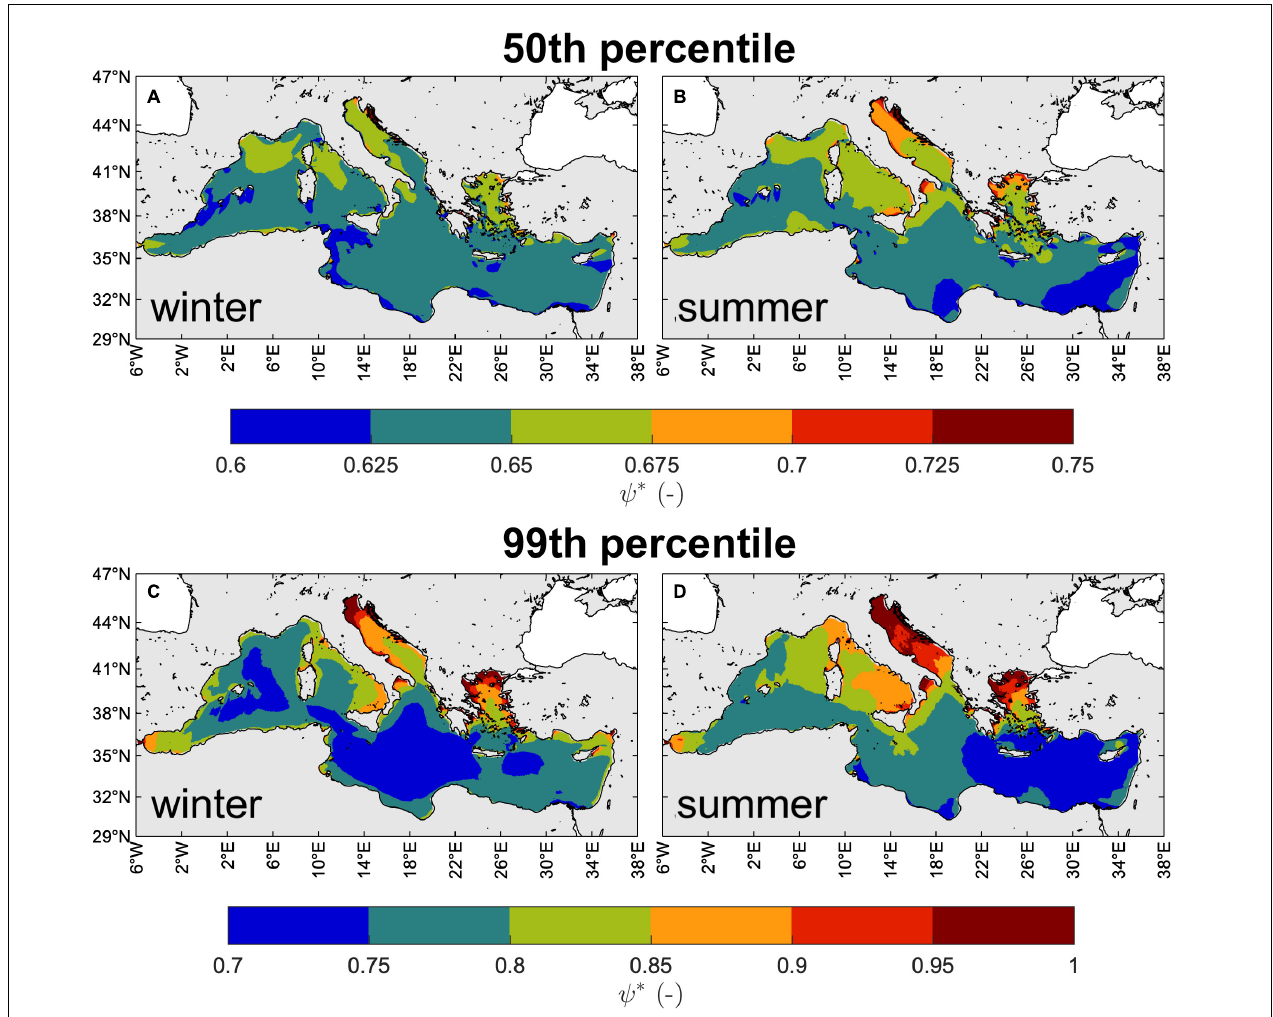
FIGURE 13 | Yearly-averaged seasonal 50th [panels (A,B) ] and 99th [panels (C,D) ] percentiles of ψ ∗ (1981–2019): winter [NDJFM, panels (A,C) ], summer [JJA, panels (B,D)